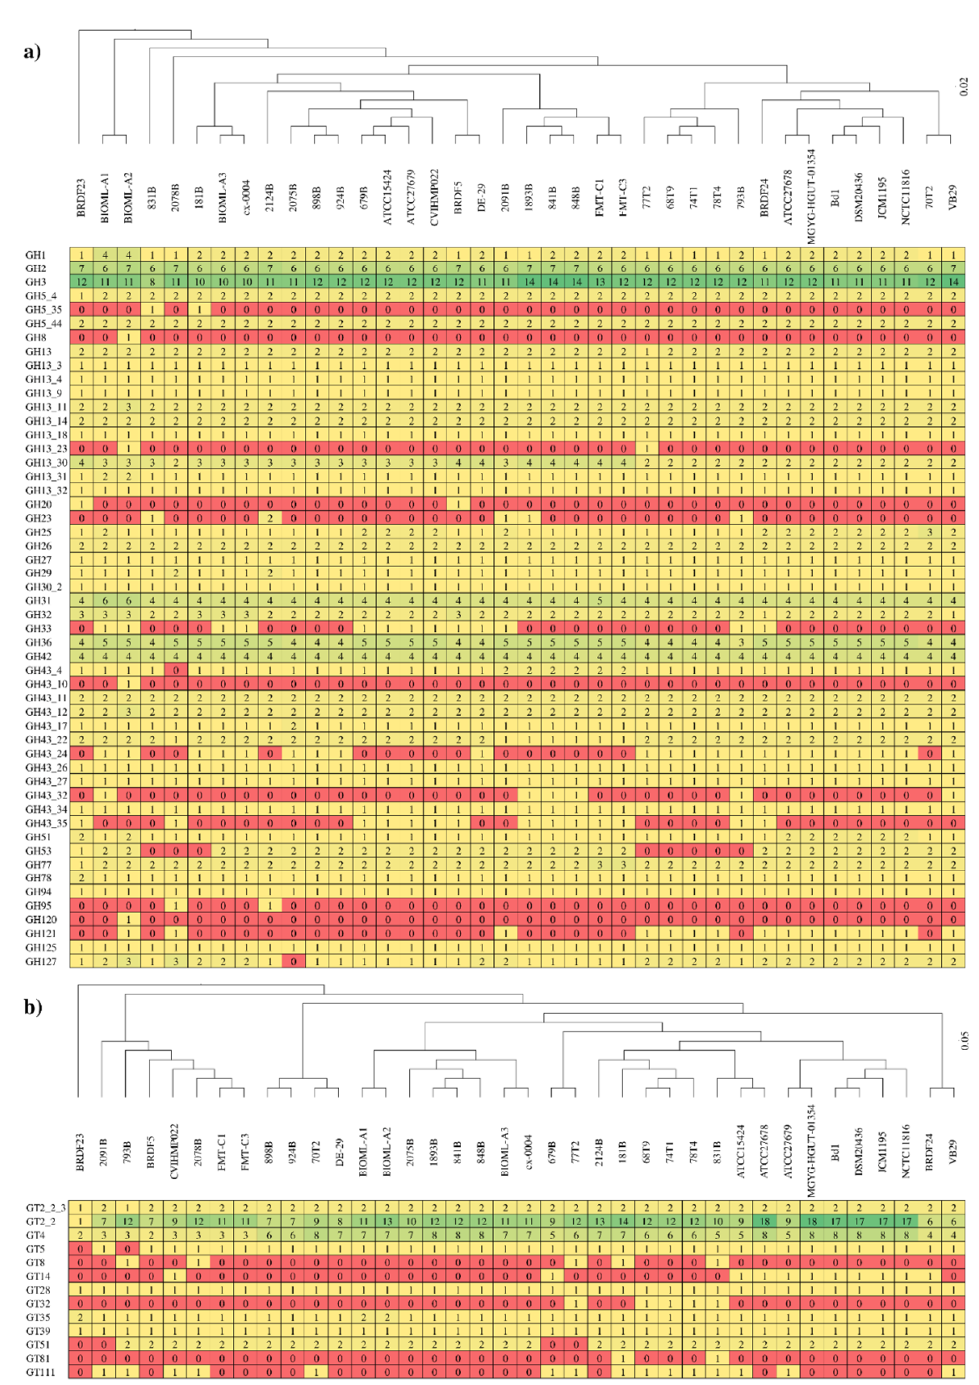
Figure 3. Carbohydrate-active enzymes of the B. dentium taxon: ( a ) displays a heat map of the glycosyl hydrolases (GHs) prediction among 38 B. dentium strains analyzed, while ( b ) exhibits a heat map of the predicted glycosyltransferases (GTs) of the same genomes. Colors reflect the abundance of the identified genes, starting from zero (red) to 18 (green). On top of both panels, hierarchical clustering is reported based on the identified GH and GT families retrieved in each strain.